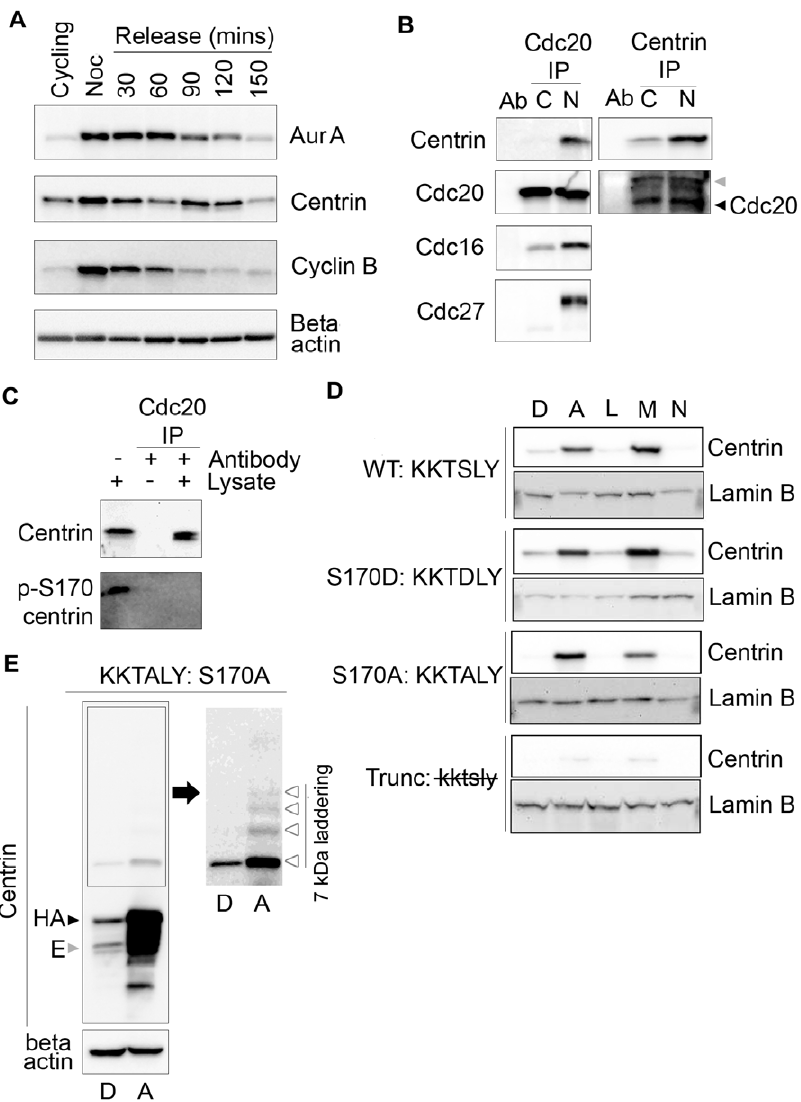
Figure 3. Centrin interacts with APC/C during mitosis. (A) Levels of Aurora A, centrin, and cyclin B were compared in Western blots of lysates of HeLa cells harvested at the indicated time points after synchronization by double thymidine/nocodazole block and release. Cyclin B degradation is used to indicate the onset of anaphase, while the beta-actin blot serves as a loading control. Aurora A and centrin levels drop to basal levels by 150 minutes post-release, while cyclin B is at basal levels by 120 minutes post-release. (B) Equal volumes of immunoprecipitations of lysates from cycling (C) or nocodazole arrested (N) HeLa cells performed with Cdc20 and centrin and Western blotted with the indicated antibodies demonstrate that centrin is pulled down with cdc20 only in nocodazole arrested cells along with Cdc16 and Cdc27. Cdc20 is pulled down with centrin in nocodazole arrested cells and to a slightly lesser extent in cycling cells. The antibody heavy chain and cdc20 were indicated with ( b ) and ( b ), respectively. (C) In lysates from asynchronously growing HeLa cells only non-phosphorylated centrin immunoprecipitates with cdc20. Cdc20 does not pull down phosphorylated centrin even though p-S170 centrin is abundant, as seen in the lysate-only lane. (D) HeLa Tet-On cells expressing various centrin mutants treated overnight with DMSO (D), ALLnL (A), leupeptin (L), MG132 (M), and ammonium chloride (N) and Western blotted with antibodies directed against total centrin reveal that DMSO, leupeptin, and ammonium chloride do not prevent centrin degradation, whereas ALLnL and MG132, the two proteasome inhibitors, do prevent degradation of wildtype and mutant forms of centrin. Lamin B loading controls are shown for each mutant cell line. (E) Lysates from HeLa Tet-On cells expressing S170A centrin treated with DMSO (D) or ALLnL (A) for 16 hours were Western blotted for centrin and beta-actin show significant degradation products in the presence of ALLnL but not DMSO. Additionally, when the boxed area of the centrin blot is over-exposed, 7 kDa laddering indicative of ubiquitination is evident ( D ). Endogenous and HA-centrin are indicated with ( c ) and ( c ), respectively.